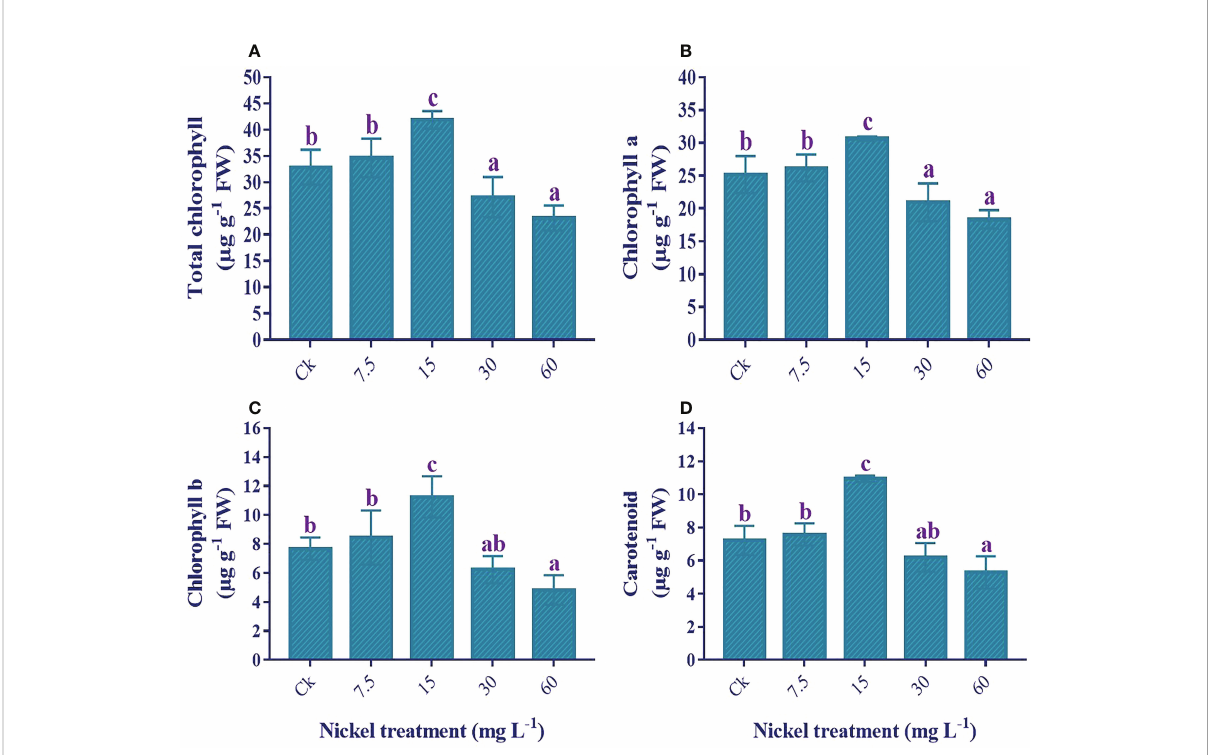
FIGURE 5 In fl uence of different Ni treatments on the photosynthetic pigments in the leaves of sweetpotato. (A) total chlorophyll, (B) chlorophyll a, (C) chlorophyll b, and (D) carotenoids. According to the Duncan test, different letters indicate a signi fi cant difference ( p < 0.05) among the fi ve treatments. The error bars represent the mean ± SE.